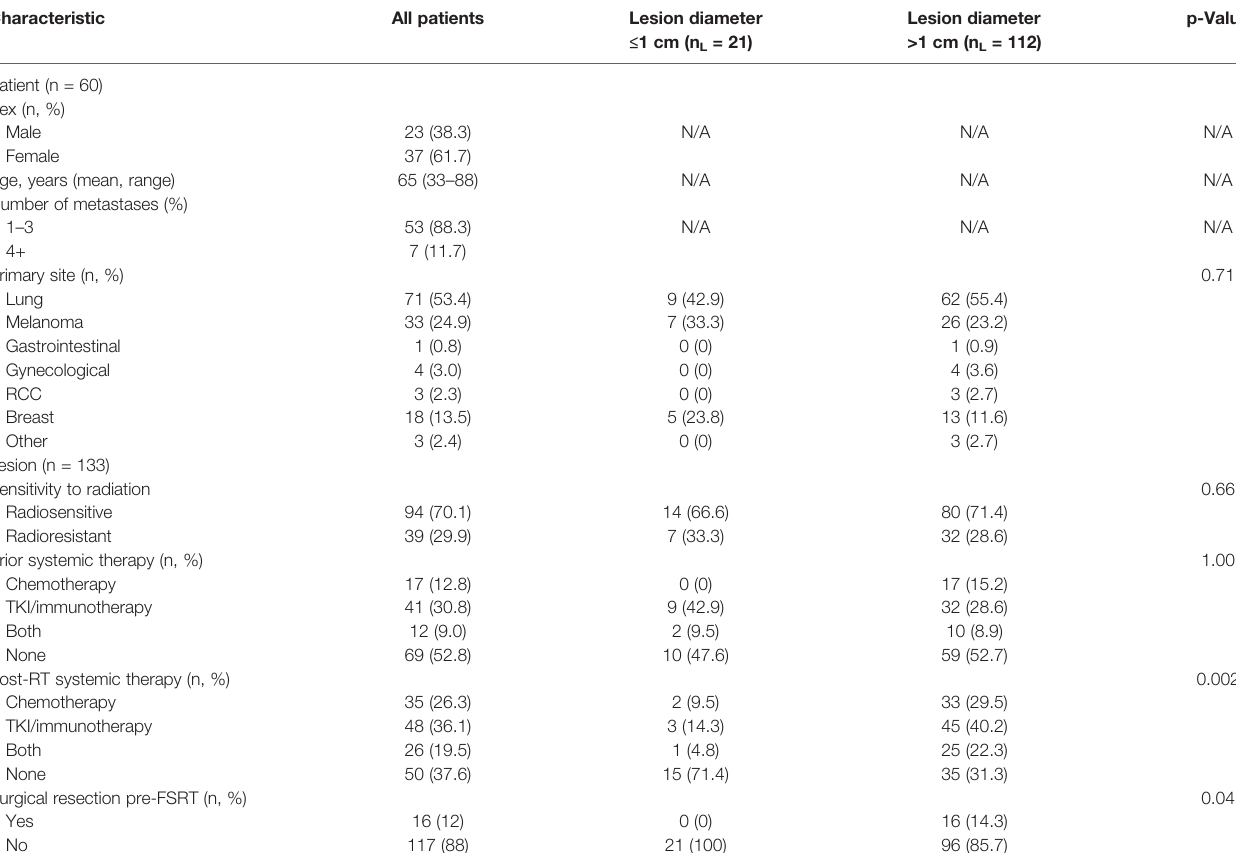
TABLE 1 | Baseline patient and lesion characteristics. Characteristic